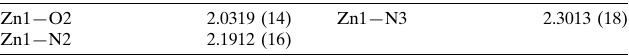
Selected bond lengths (A˚ ).